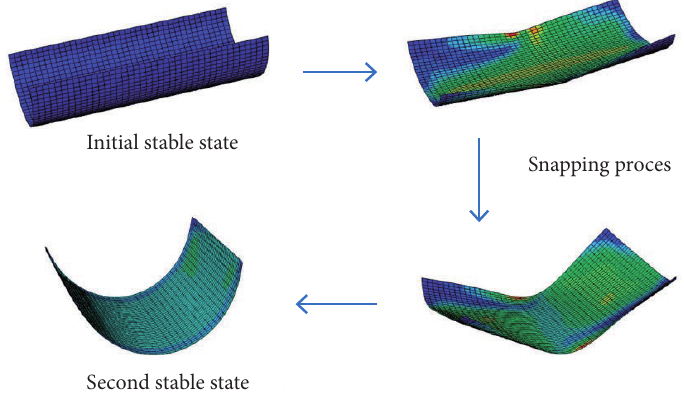
Figure 15. Two different kinds of stable configurations for bi-stable laminate structures (Zhang et al.